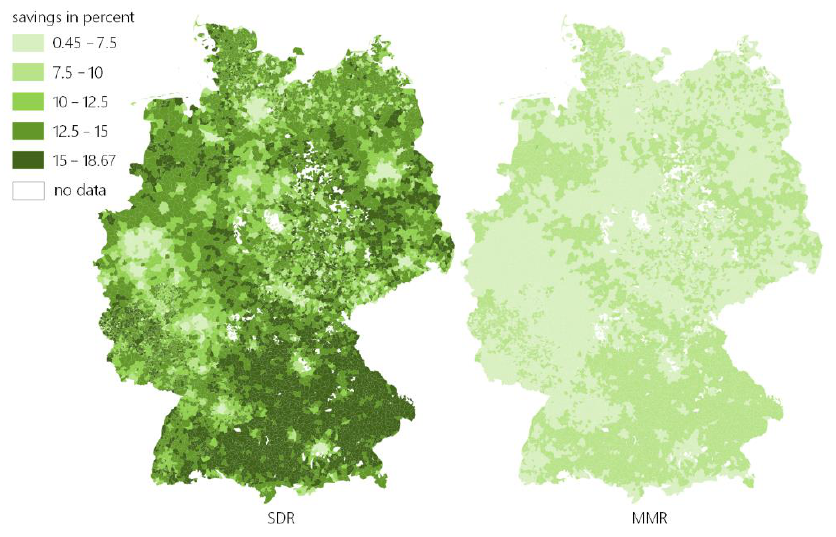
Figure 19. Regional disparities in savings from leveraging P2P buy prices versus normal retail pricing.